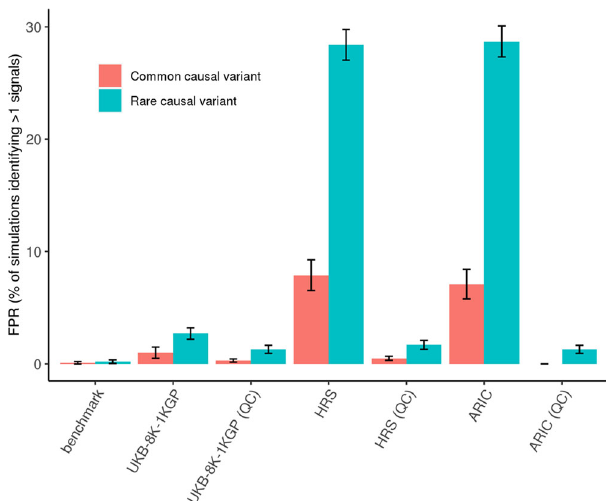
Fig. 2 FPR of COJO with and without DENTIST. Based on simulations with one causal variant, we assessed the FPR of COJO when performed with and without DENTIST-based QC (FPR is de fi ned as the frequency of observing more than one COJO signal in the scenario where only one causal variant was simulated). The x-axis labels indicate the LD reference samples, and those performed after DENTIST QC are labeled with “ QC ” in the parentheses. The height of each bar shows the FPR estimated from 2200 simulation replicates, with each error bar representing ± one s.e. of the estimate. Source data are provided as a Source Data fi le.